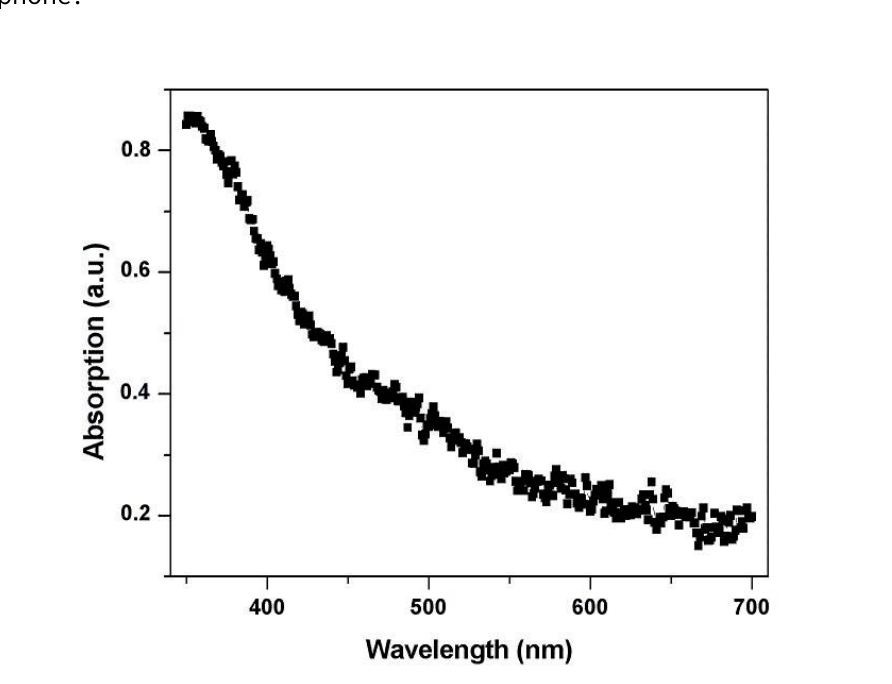
Figure 11. Absorption spectrum obtained for sample 2 with the electret microphone.